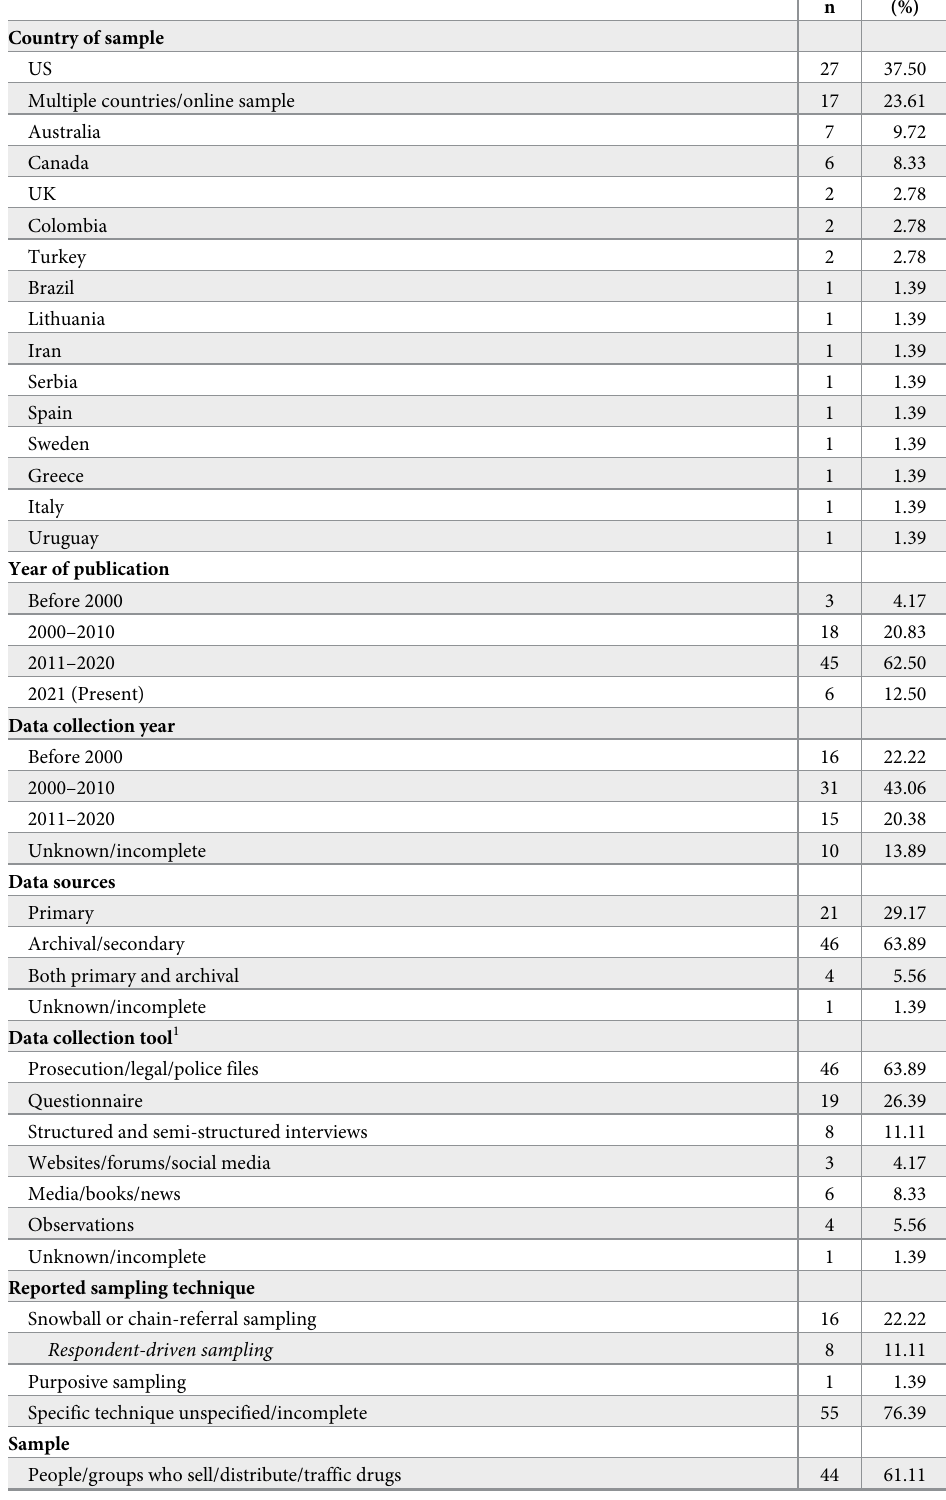
Table 1. Summary of studies included in scoping review (n =